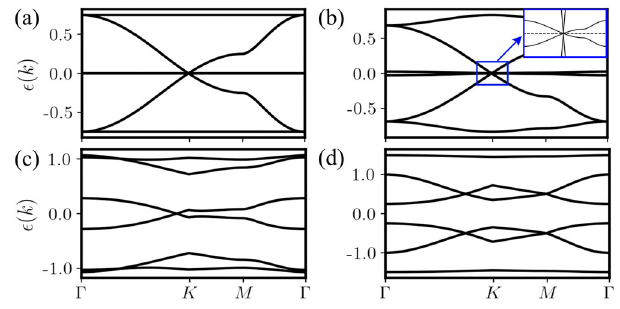
Fig. 3 Band structure of itinerant Majorana fermions. a The Majorana band structure of the quadratic Hamiltonian H (2) at the isotropic point J z = 1 and D z = 0. The Majorana band structures of the MF Hamiltonian H MF with ( b ) J z = 1 and D z = 0, ( c ) J z = 1.2 and D z = 0.4, and ( d ) J z = 1.4 and D z = 0. Here J x = J y = 1, and a zero- fl ux con fi guration of { u } = 1 is used. The inset in ( b ) shows the zoom-in around the K